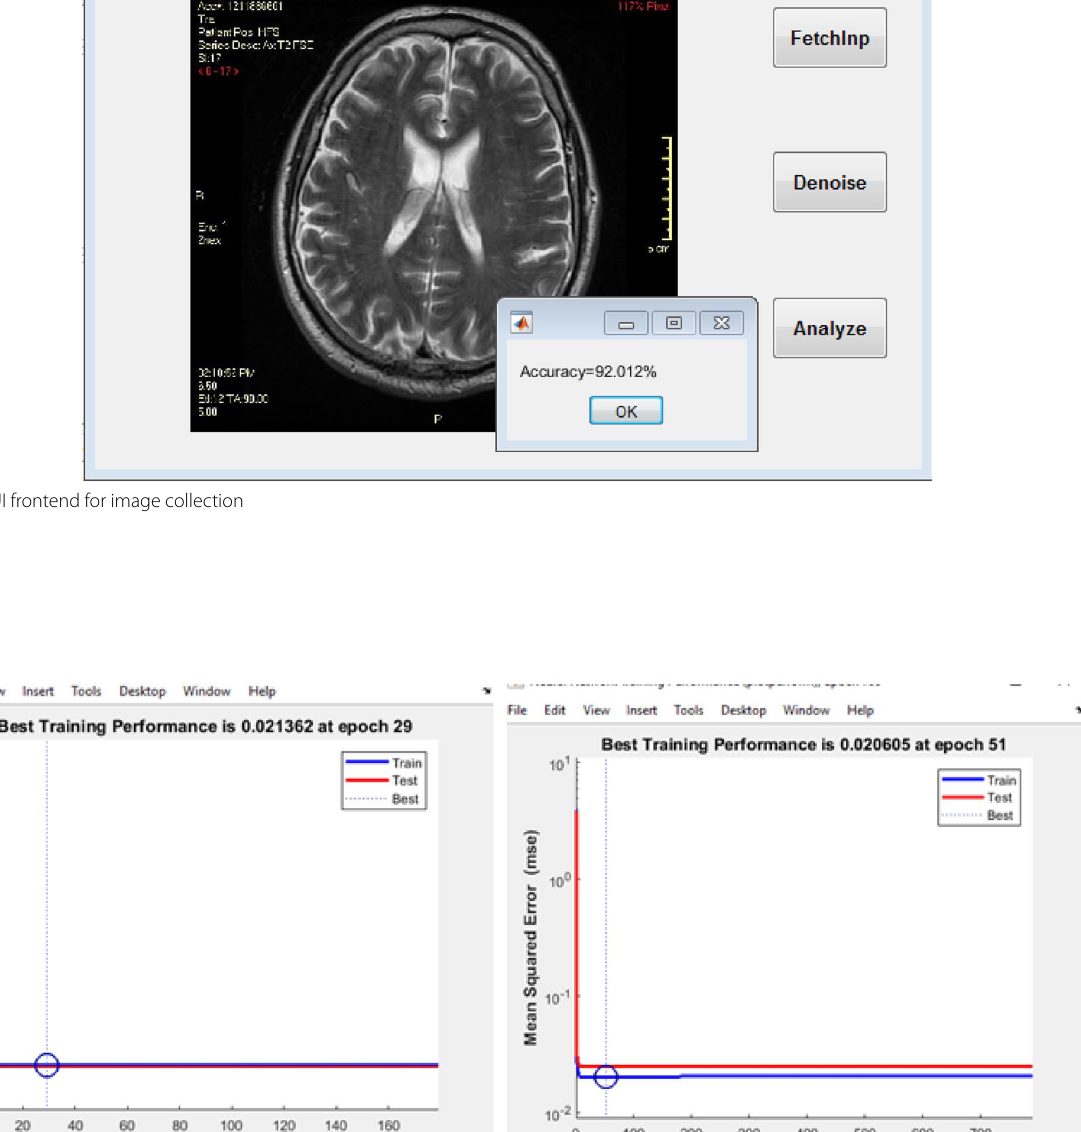
are displayed as the error spots over here. The error differences denote the mean outcome of the com- plete iterations computed by the Deep neural network architecture.